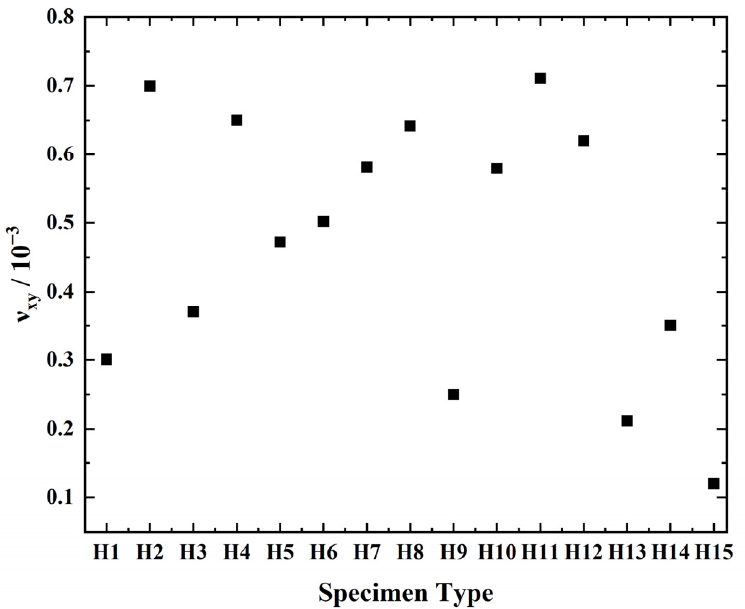
Figure 8. Experimental test results of Poisson’s ratio of four-pointed star structure.